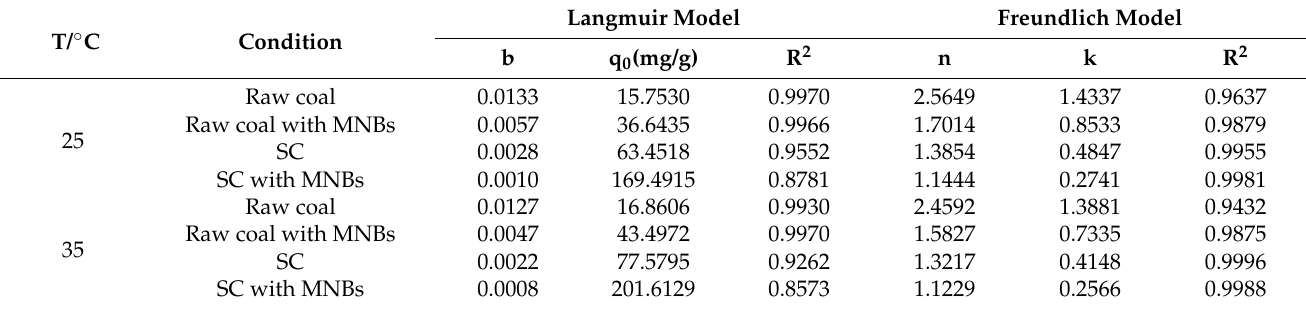
Table 3. Comparison of SC with MNBs and